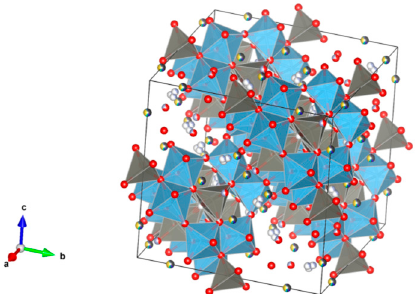
Figure 4. Murataite. A 6 B 12 C 5 TX 40-x . Structure: Cubic, Sp. gr. F4m. Cations can be U, Np, Pu, Am, Cm and REE, including Gd (a neutron absorber).